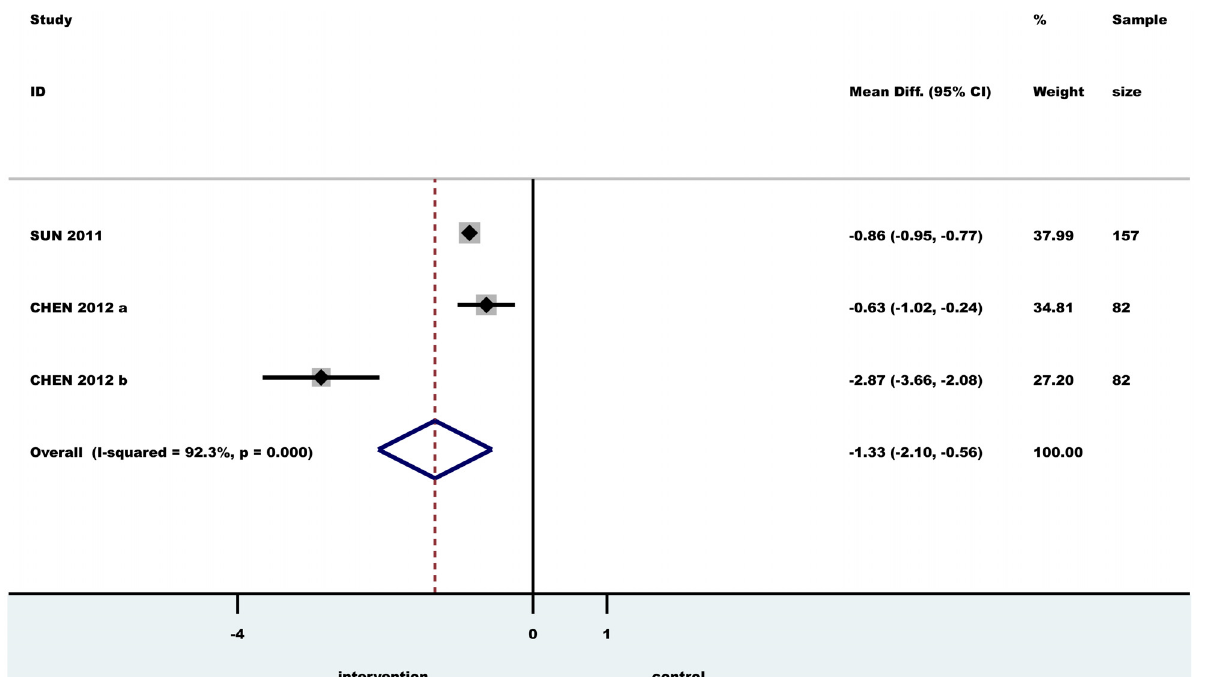
Fig 2. Forest plot of the difference between Δ TNF- α test and control individuals in randomized controlled trials. Horizontal lines representing 95% CI; diamond represents the overall effect size, random effects models.